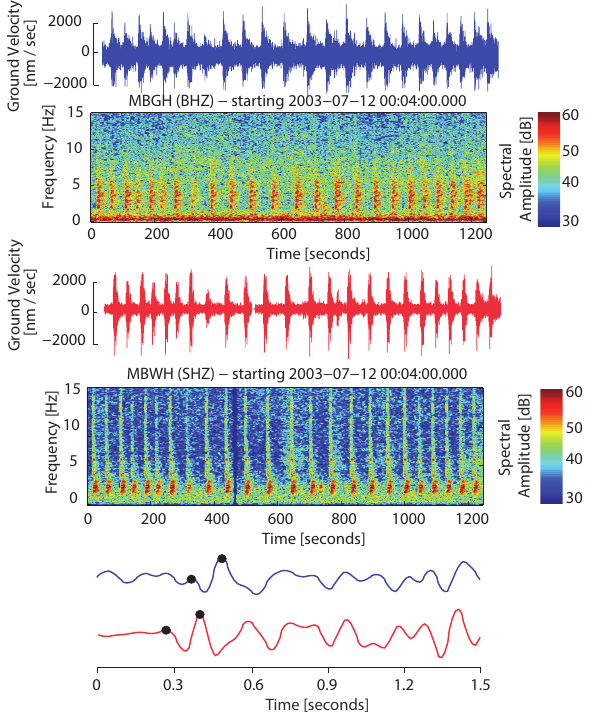
Fig. 9. Repetitive seismicity at Soufrière Hills volcano. Seismo- grams for 18min of repeating earthquakes at stations MBGH and MBWH recorded on 12 July 2003 approximately 12hr before the largest dome collapse in SHV history. Bottom panel: The black dots highlight the width of a single P-wave pulse from the seismograms above, which provide an estimate of source duration.